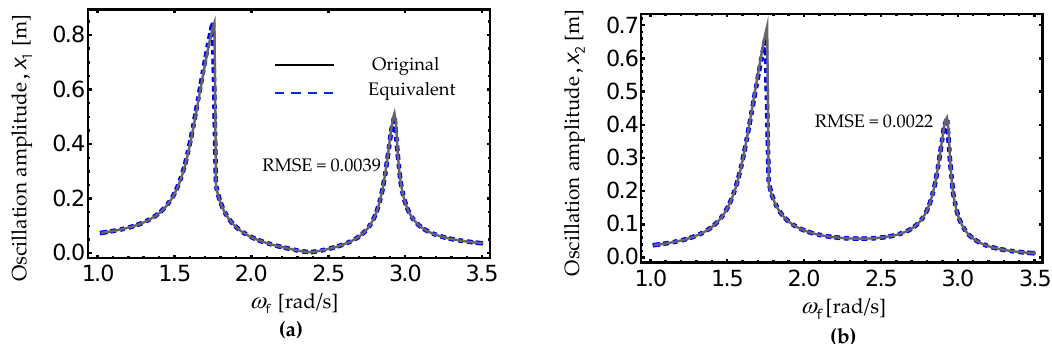
Figure 6. Frequency-amplitude response curves: ( a ) x 1 vs ω f , ( b ) x 2 vs ω f . These were computed from the numerical integration solutions of Equations (36) and (42). The parameter values used to obtain these plots were m 1 = 1 kg, m 2 = 1.5 kg, k 1 = 2 N/m, k 2 = 3.5 N/m, k 3 = 5 N/m, c 1 = 0.066 N-s/m, c 2 = 0.099 N-s/m, ε 1 = 1 N /m 3 , ε 2 = 1 N/m 3 , Q 1 = 0.2 N. Here, the black, solid lines describe the numerical integration solutions of Equations (36), while the blue, dashed lines represent the numerical solutions obtained from the derived equivalent nonlinear equations of motion (42).